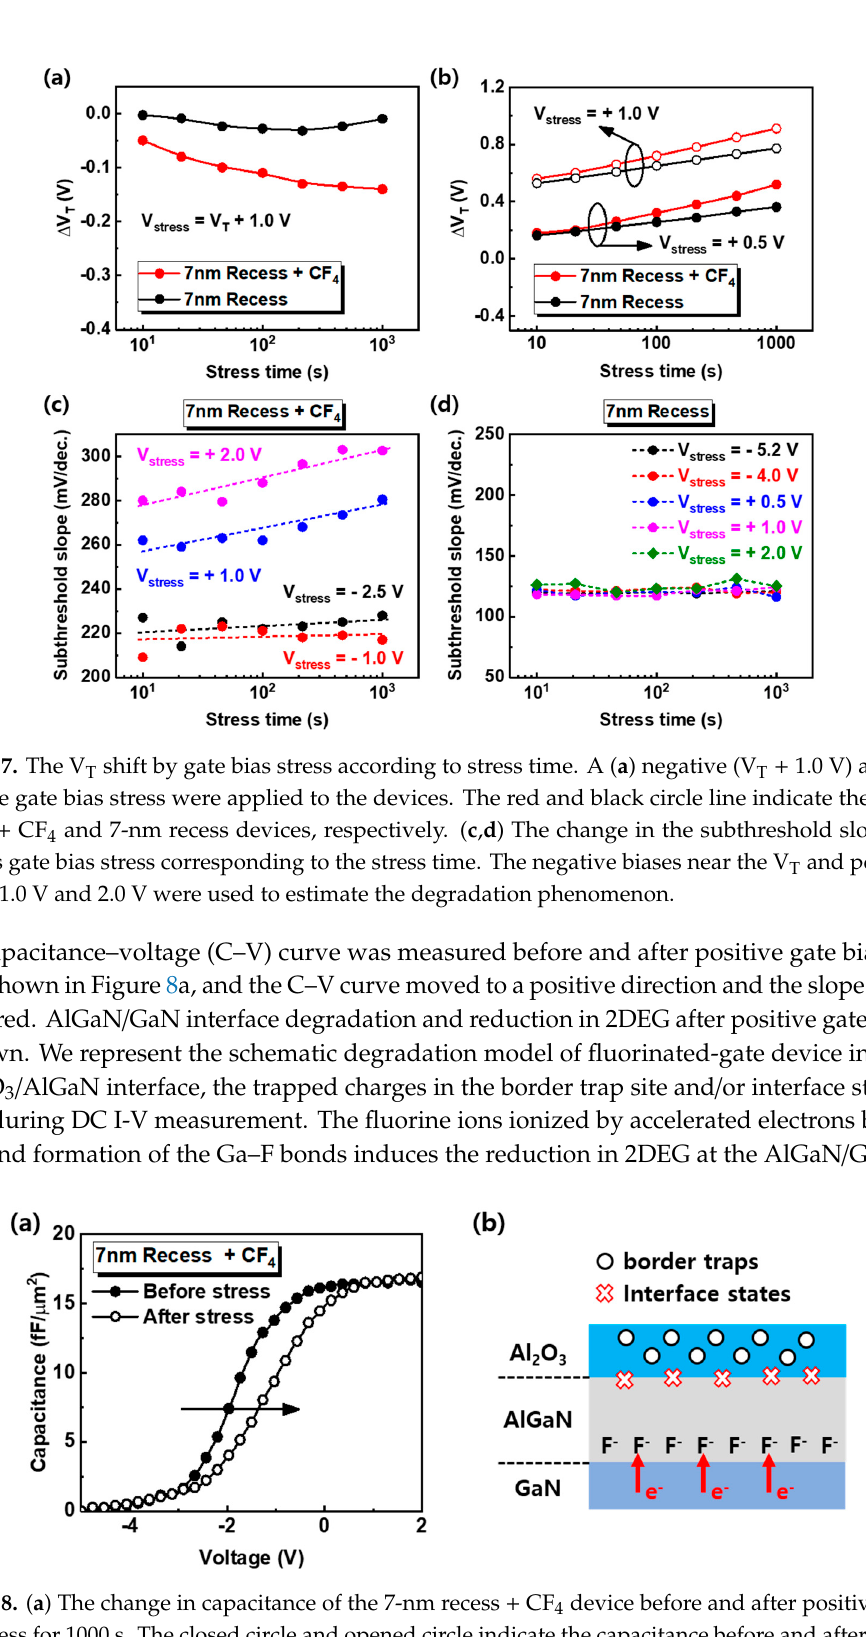
Figure 6. ( a , b ) The change in I-V transfer curves of the 7-nm recess + CF 4 device under negative and positive gate bias stress conditions according to stress time, respectively. ( c , d ) The change in I-V transfer curves of the 7-nm recess device under negative and positive gate bias stress conditions, respectively.